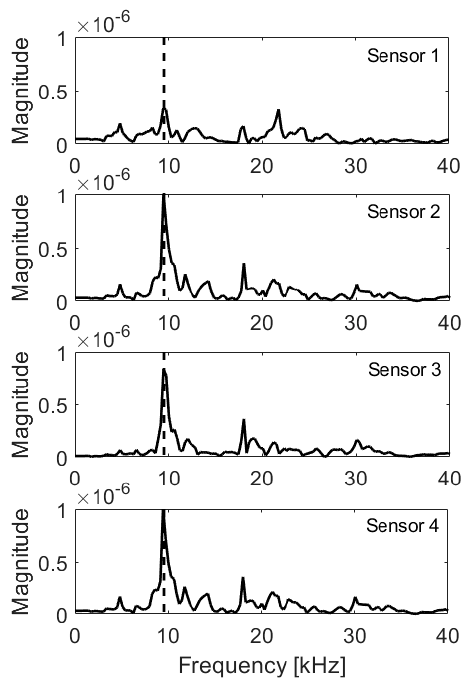
Figure 10. Frequency spectra, void below sensor 1; expected frequency marked with dashed line.